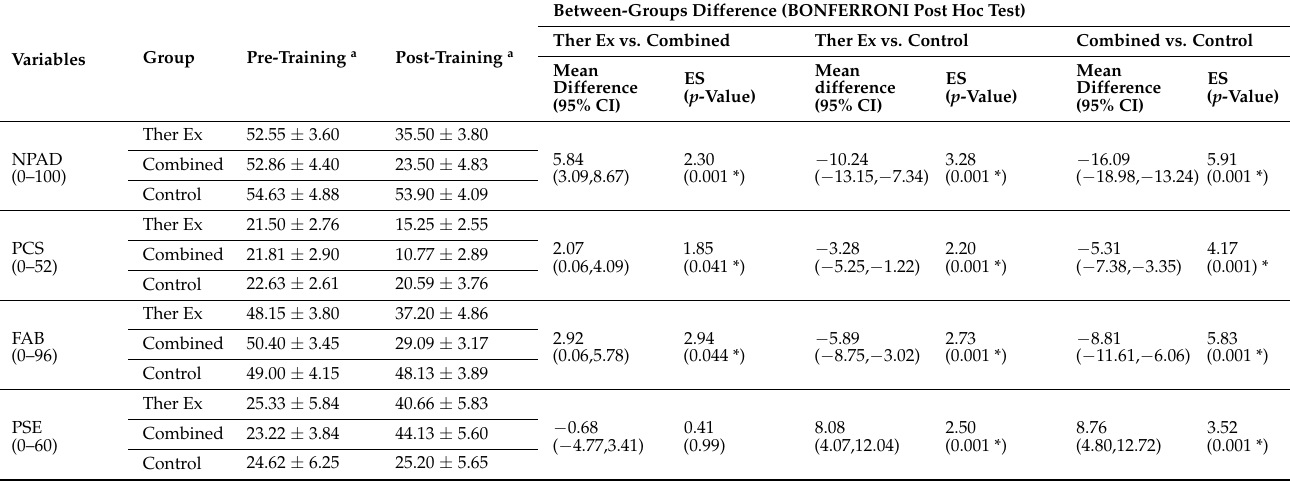
a Mean ± standard deviation. ES = effect size, Ther Ex = therapeutic exercises, combined = therapeutic exercises + pain neuroscience education, CI = confidence intervals, NPAD = Neck Pain and Disability Scale, FAB = fear–avoidance beliefs, PCS = Pain Catastrophizing Scale, PSE = pain self-efficacy. * Statistically significant difference ( p <